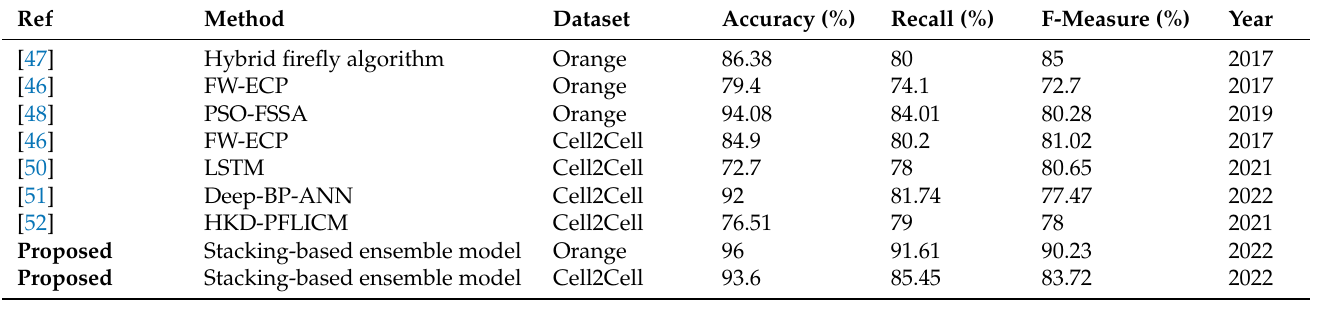
Table 2. Comparison with state-of-the-art approaches.